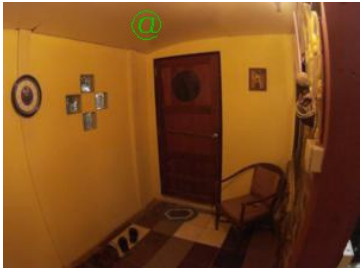
Figure 11. “@ symbol”.